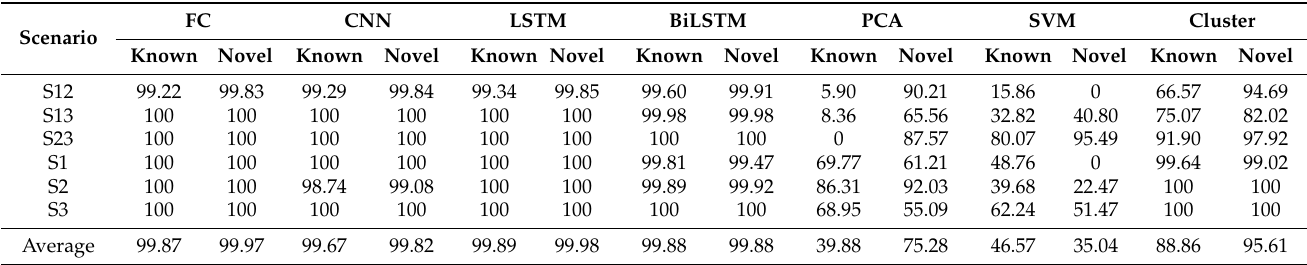
Table 3. Evaluation of the effectiveness in normal operating conditions: F1 Score on the Known and Novel